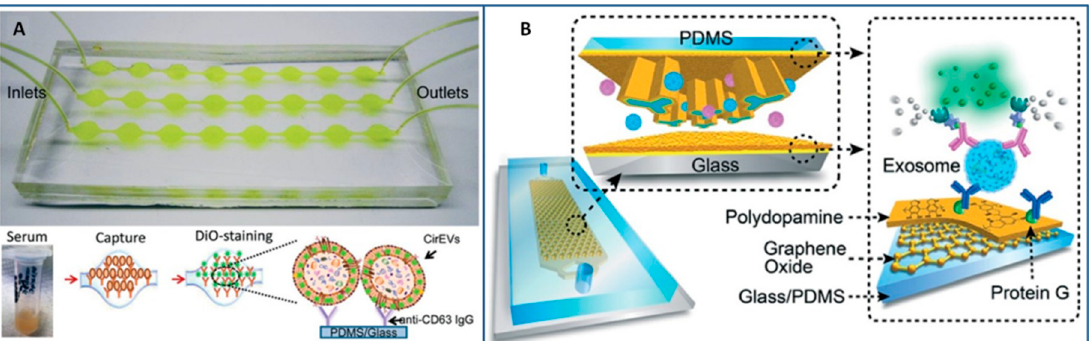
Figure 2. Immunoaffinity methods to trap exosomes. ( A ) Prototype of the Exochip and scheme of exosome immobilization through a CD63-antibody coating during serum flow. Reproduced with permission from reference [115]; ( B ) Nano-IMEX chip consisting of an array of Y-shaped microposts; focus on the functionalization with graphene oxide (GO) and polydopamine (PDA) to obtain an enzyme linked immune-sorbent assays (ELISA)-like assay with enzymatic fluorescence signal amplification. Reproduced with permission from reference [135].